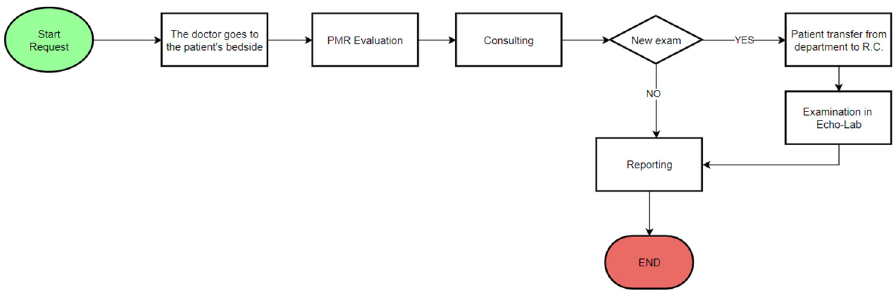
Figure 2. Flow chart of the consultation process before the Lean management intervention.